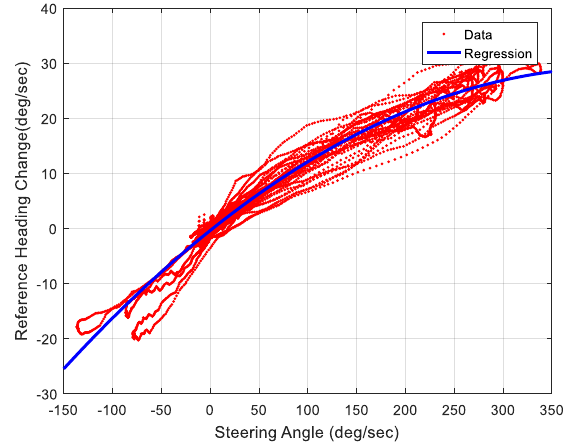
Figure 10. CPD regression model between the steering angle